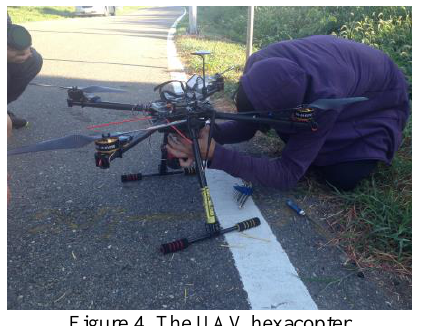
Figure 4. The UAV hexacopter